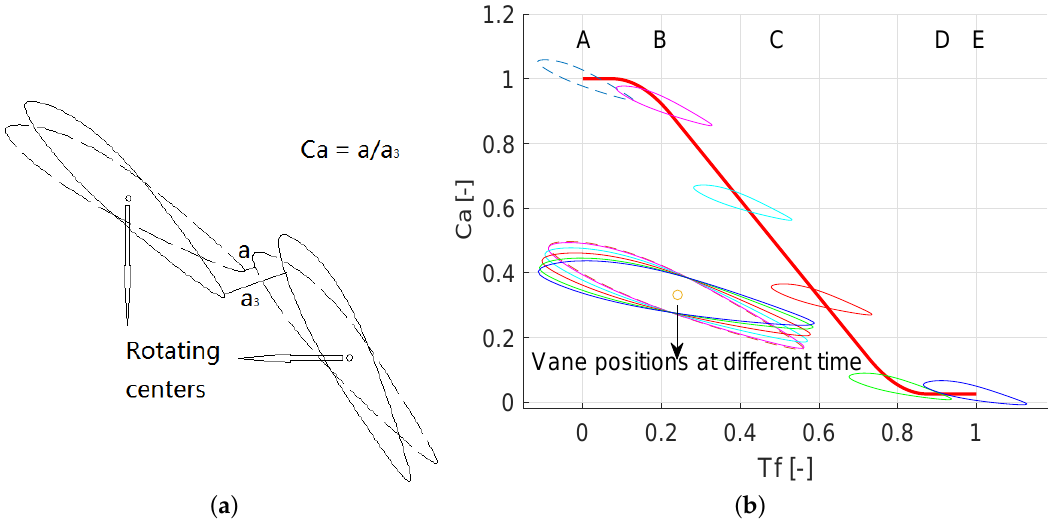
Figure 5. ( a ) Definition of relative opening Ca ; and ( b ) representation of the closing law of guide vanes with the illustration of vane positions at different times: A is the fully-open position; B represents the position at T = 1.28 s; C represents the position after half time; D represents the position at T = 5.76 s; E is the final closing